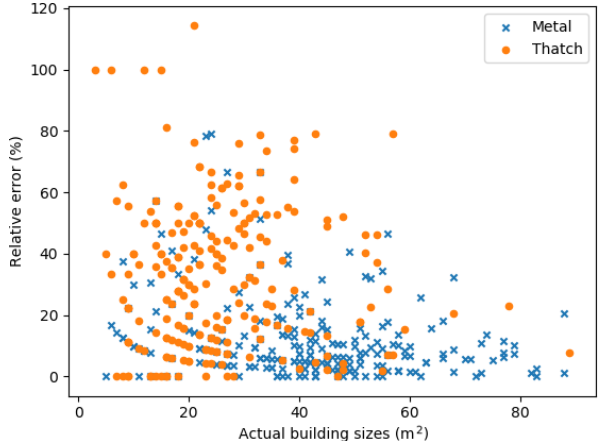
Figure 10. Building area and relative error for both types (metal and thatch) in the case study